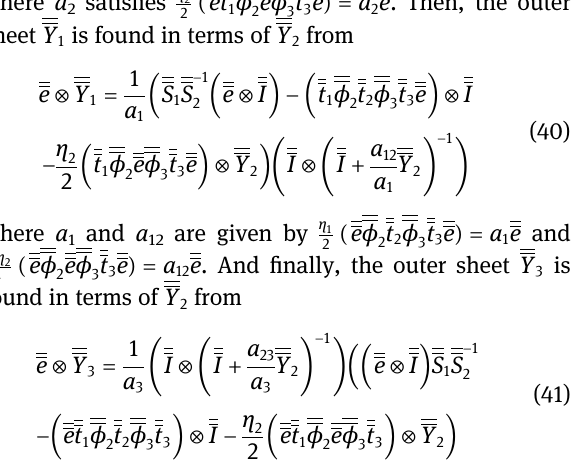
Figure 2: A metasurface consisting of three cascaded electric sheet admittancesdesignedtorealizeastipulatedSmatrix(reprintedwith permission from